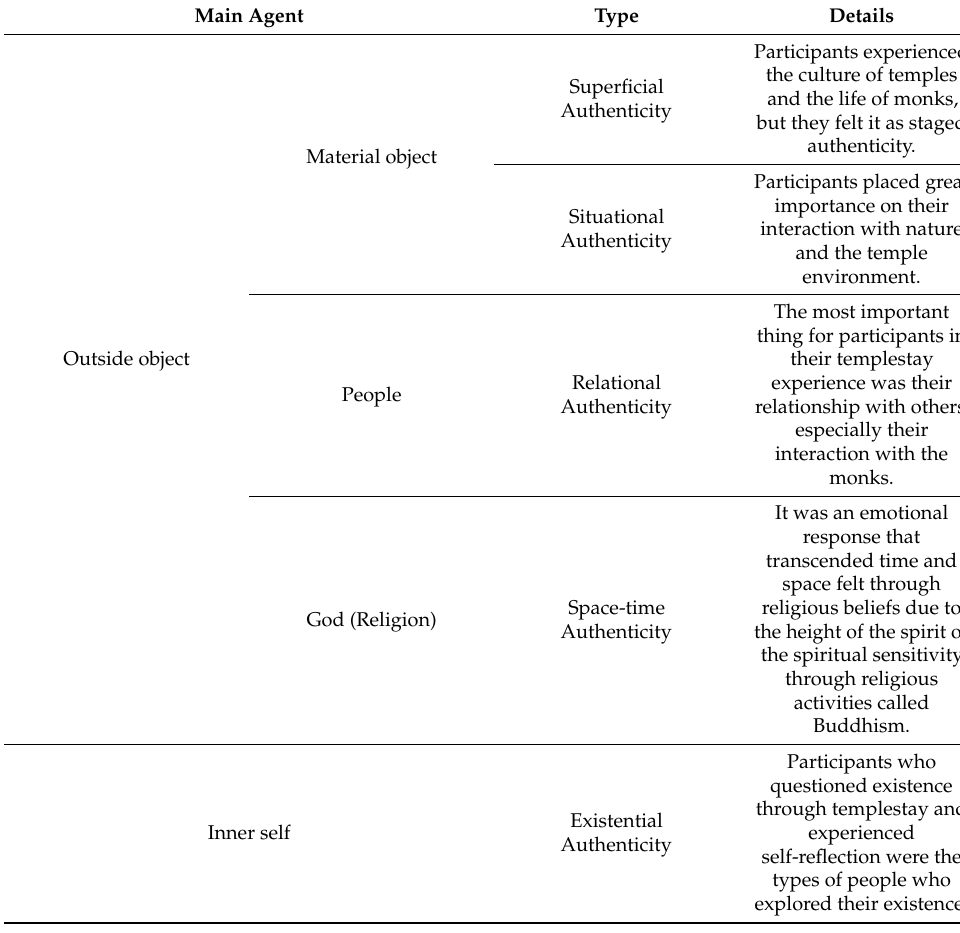
Table 2. Types of templestay